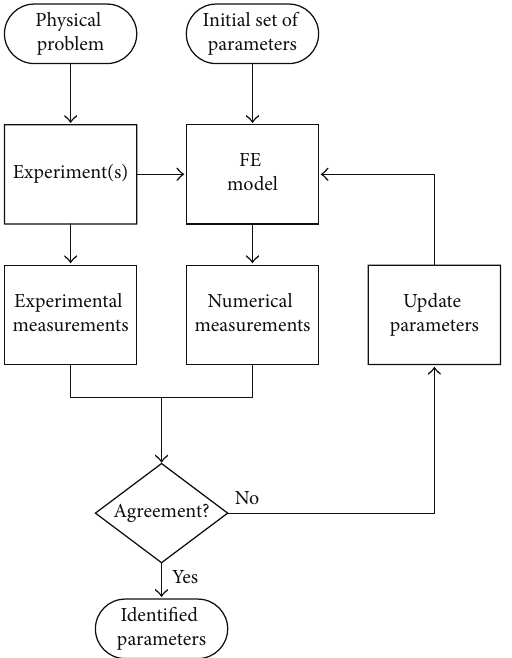
Figure 2: Schematic representation of inverse identification strate- gies. Adapted from